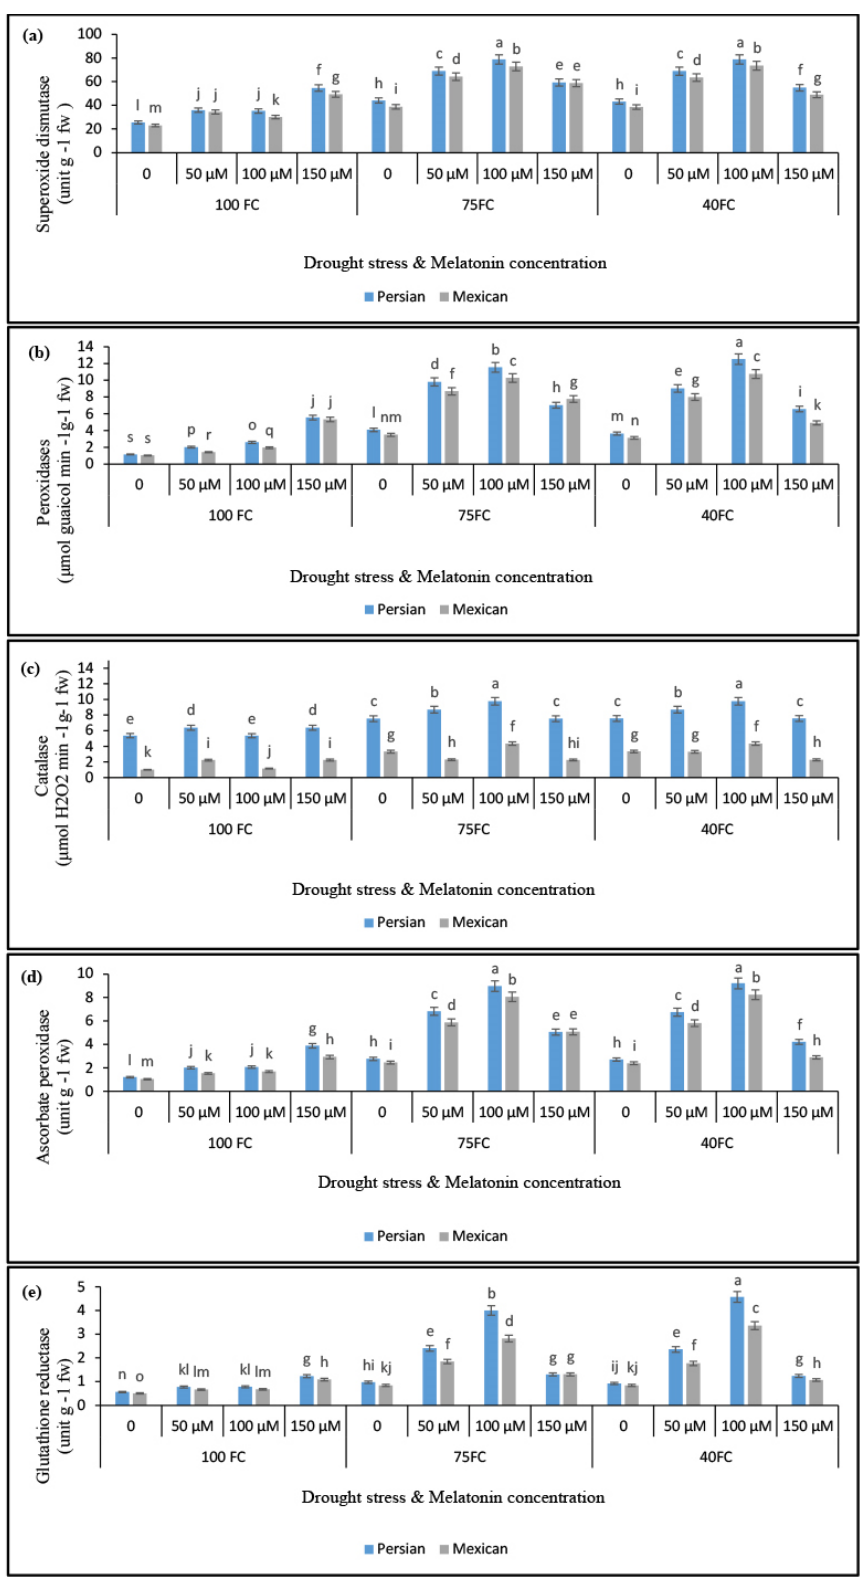
Figure 1. The effects of different concentrations of exogenous melatonin, Citrus species, and various levels of drought stress on the activities of antioxidant enzymes including ( a ) superoxide dismutase, ( b ) peroxidase, ( c ) catalase, ( d ) ascorbate peroxidase, and ( e ) glutathione reductase. Based on the LSD test, columns with similar letters are not significant at the 5% probability level.